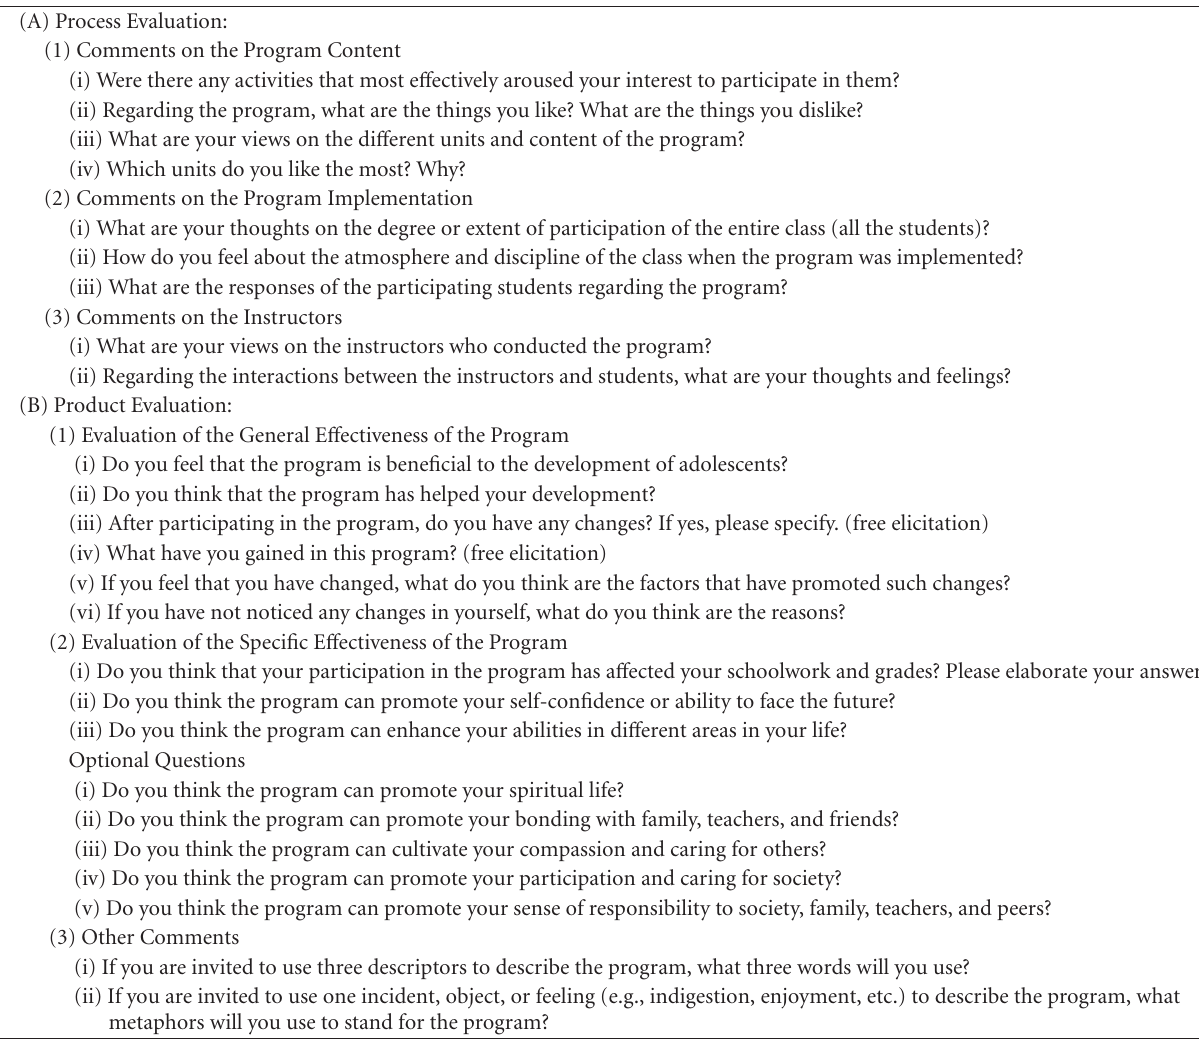
Table 2: Interview guide for the student focus